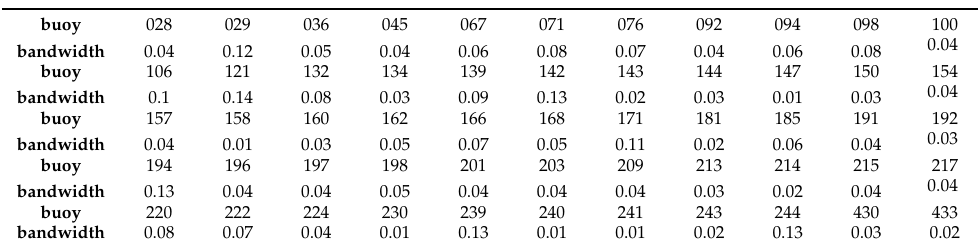
Table A3. Bandwidth, per buoy, rounded to 2 decimal values used for the kernel density estimated curves in Figure